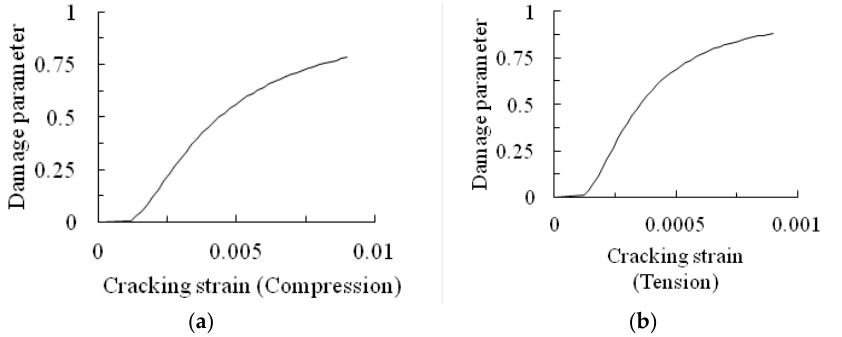
Figure 10. Input curves used in ABAQUS for damage evolution in: ( a ) compression; ( b ) tension.